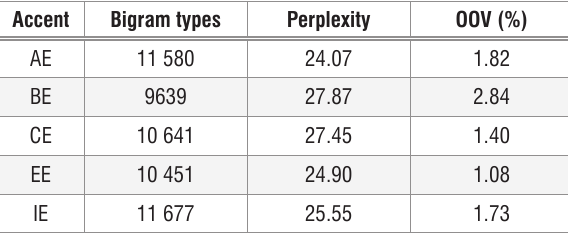
Table 3: Bigram language model perplexities and out-of-vocabulary (OOV) rates measured on the evaluation sets